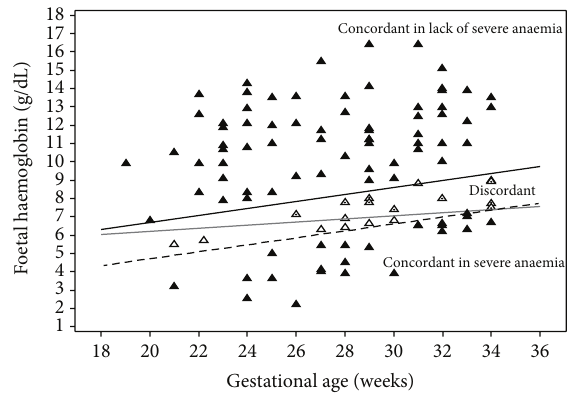
Figure 2: Fetal hemoglobin concentration values assessed at first cordocentesis, plotted under the severe anemia diagnosis threshold, according to the anemia different criteria. Solid triangles: concor- dant cases. Hollow triangles: discordant